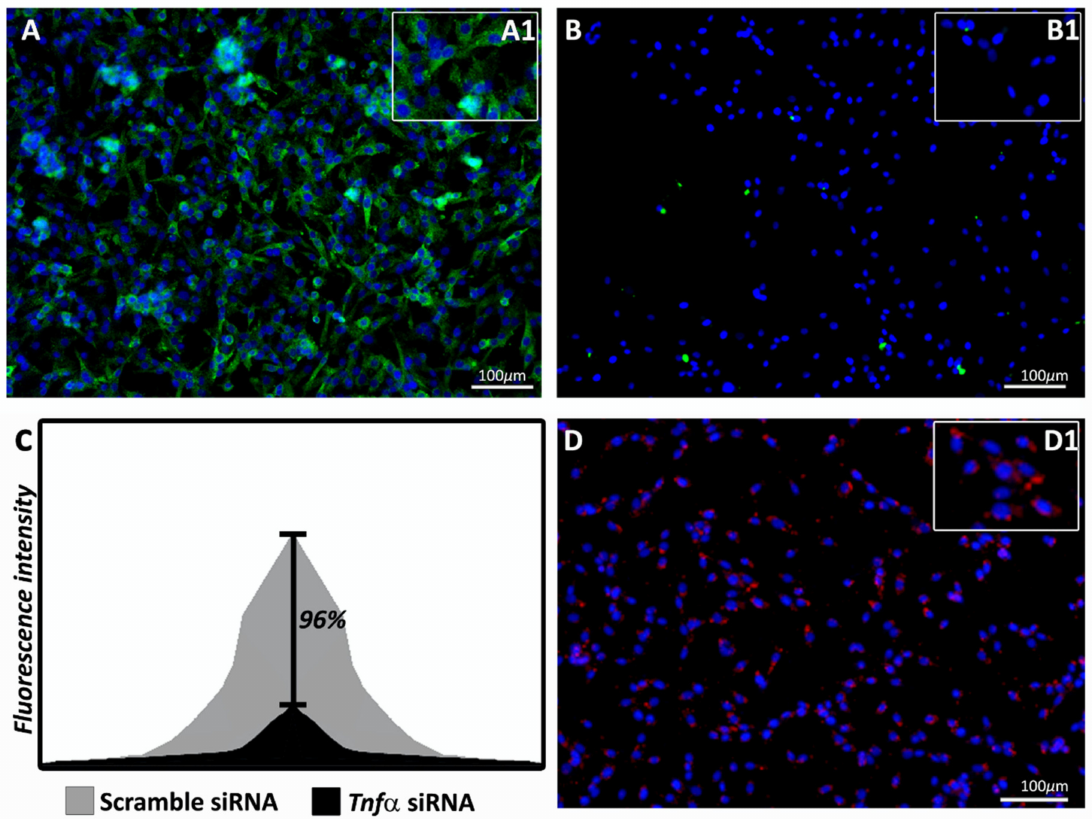
Figure 1. Fluorescence analysis of tumor necrosis factor α (TNF α ) (green-labeled) in glial fibroblast cells treated with scramble small interfering RNA (siRNA) (negative control-A) or Tnf α siRNA ( B ). Shown in ( C ) is the silencing rate of the fluorescence intensity between the scramble siRNA and Tnf α siRNA (black bar, 96%). In ( D ) is the positive control of the delivery agent (red-labeled). The fluorescence of nine sites per well, with a total of three wells per treatment, was analyzed by MetaXpress software. Statistical di ff erences in the values of TNF α labeling ( A and B ) were obtained using Student’s t -test, with the Bonferroni post-hoc test, at a significance level of 5% ( p < 0